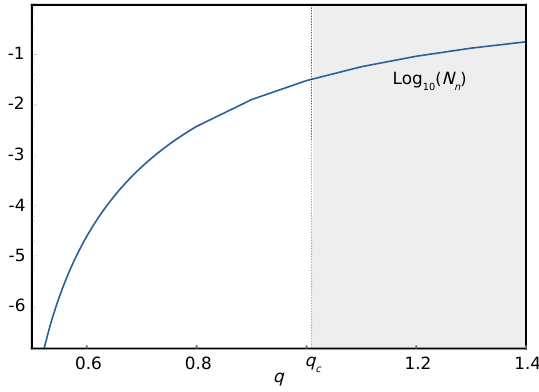
Figure 3 . Radial profiles for a nematic domain wall at q = 2 . Left: Q 1 (upper line) and Q 2 (lower line). Right: the functions f (upper line), N (middle line) and − h (lower line). These profiles are given by integrating from eqs. (4.7)–(4.11).